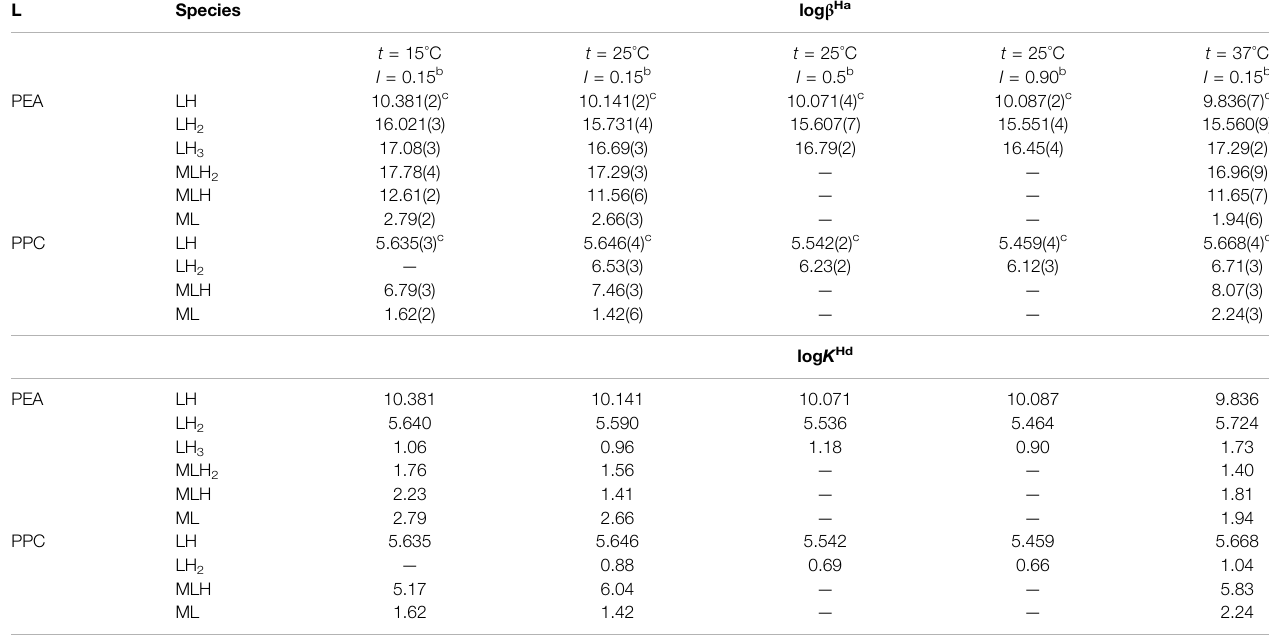
TABLE 1| Experimental valuesofprotonation constantsofPEA and PPC and formationconstantsofMg 2+ speciesobtainedbypotentiometry atdifferenttemperaturesand ionic strength values in NaCl. L